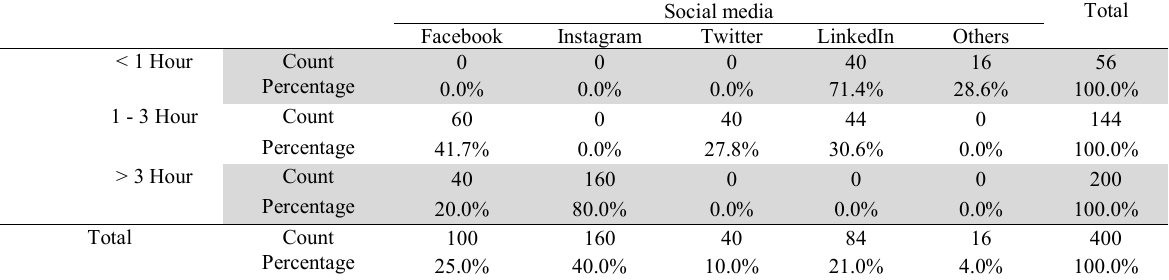
Crosstabulation Frequency Use Social Media and Flatform Social Media Social media Total Facebook Instagram Twitter